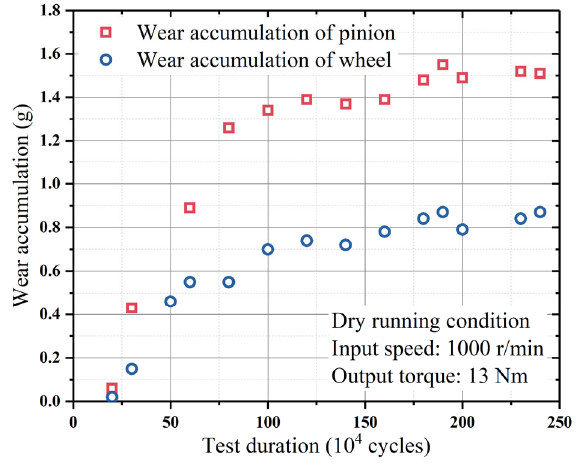
Fig. 13 Wear accumulation for the 13 N · m load under the dry running